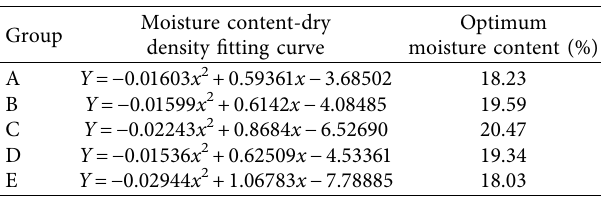
Figure 4: Moisture content-dry density curve. Table 4: Fitting results of moisture content-dry density.